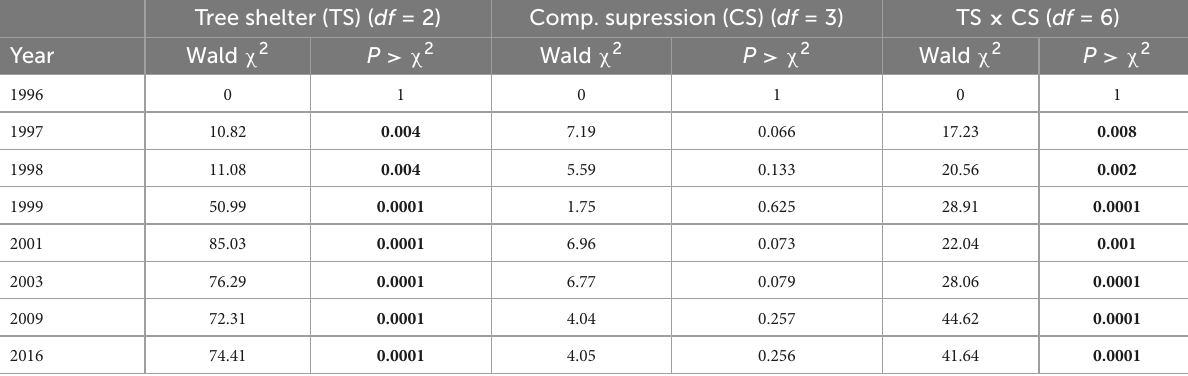
TABLE 1 Contrasts of the generalized linear model effects for survival along 20 years of Pinus halepensis planted in a factorial experiment with tree protection (no shelter, mesh, and solid tube) and four competition suppression (control, manual weeding, polyethylene mulch, and fiber mat) levels.